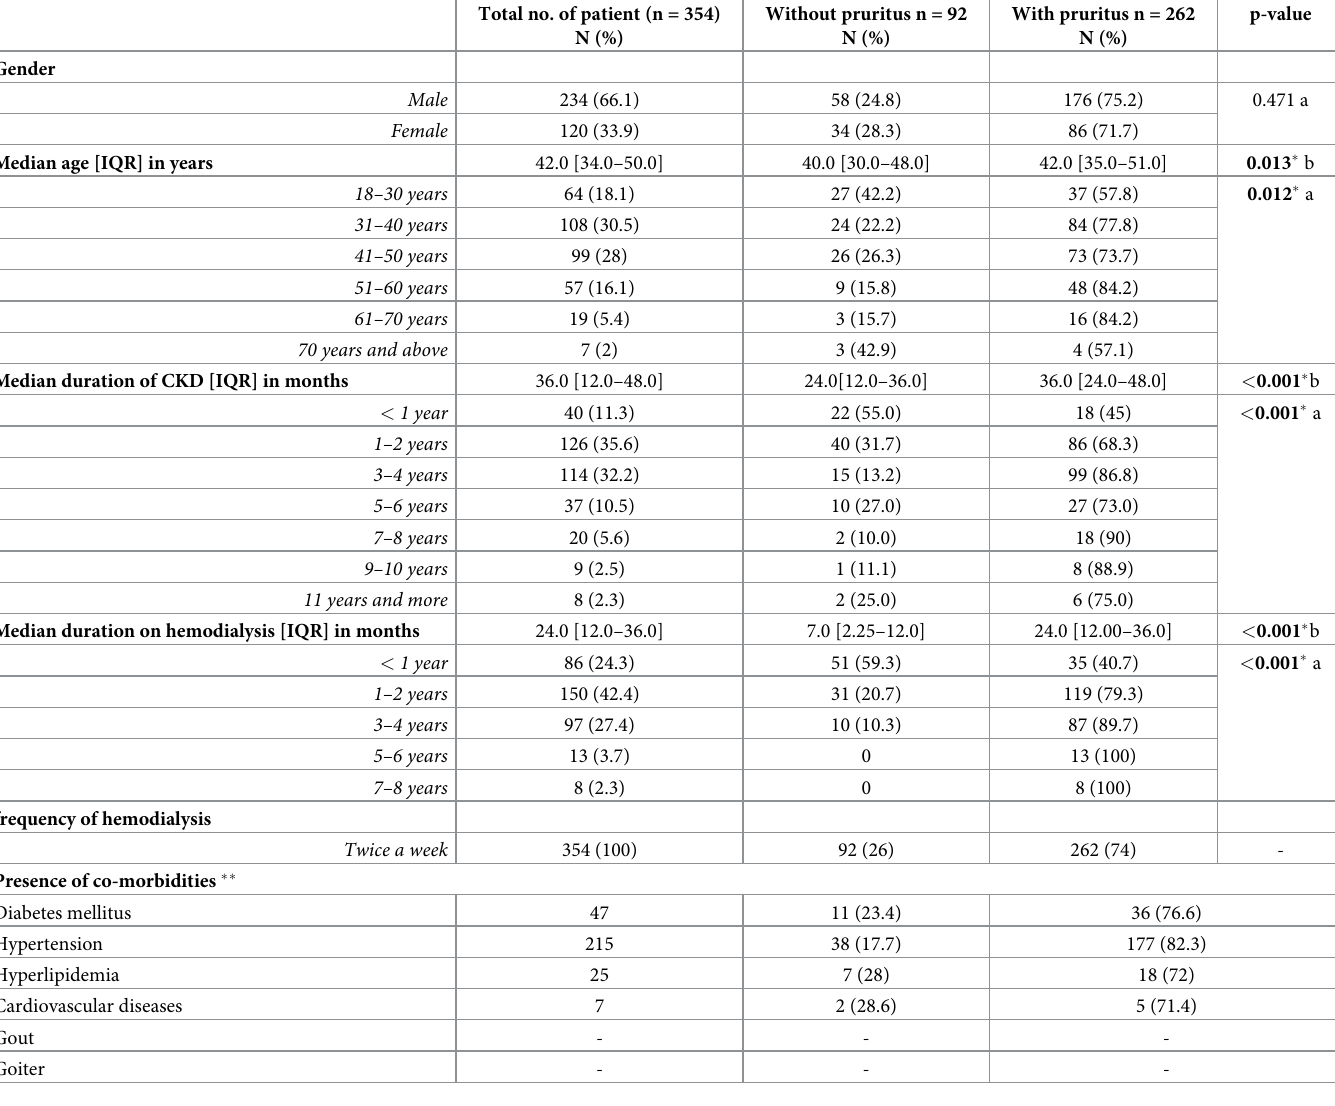
Table 1. Demographics of participants (n =